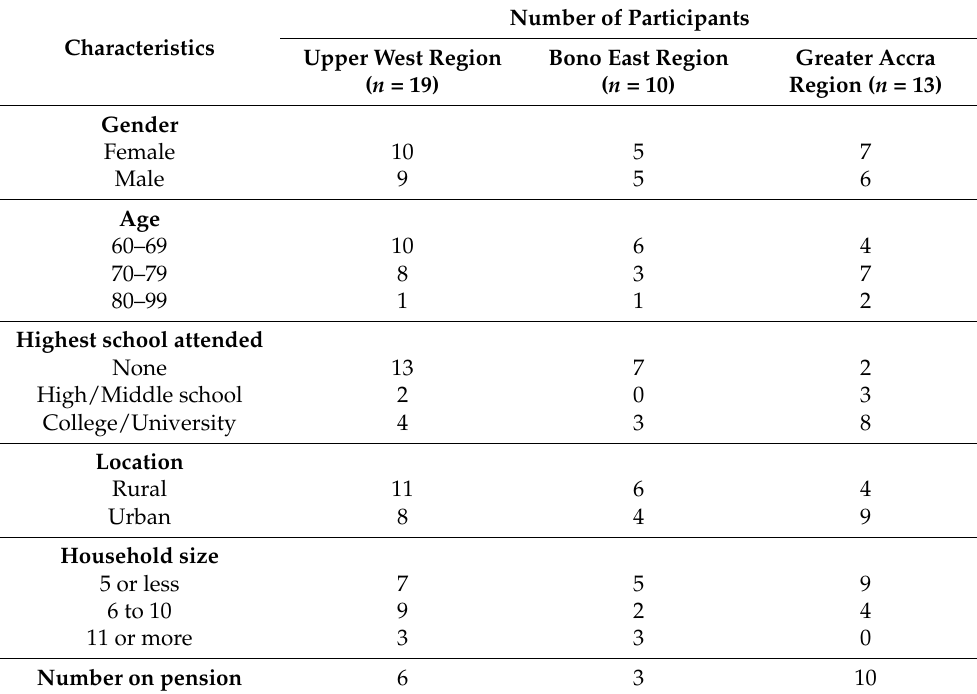
Table 1. Participants characteristics—interviews ( n =